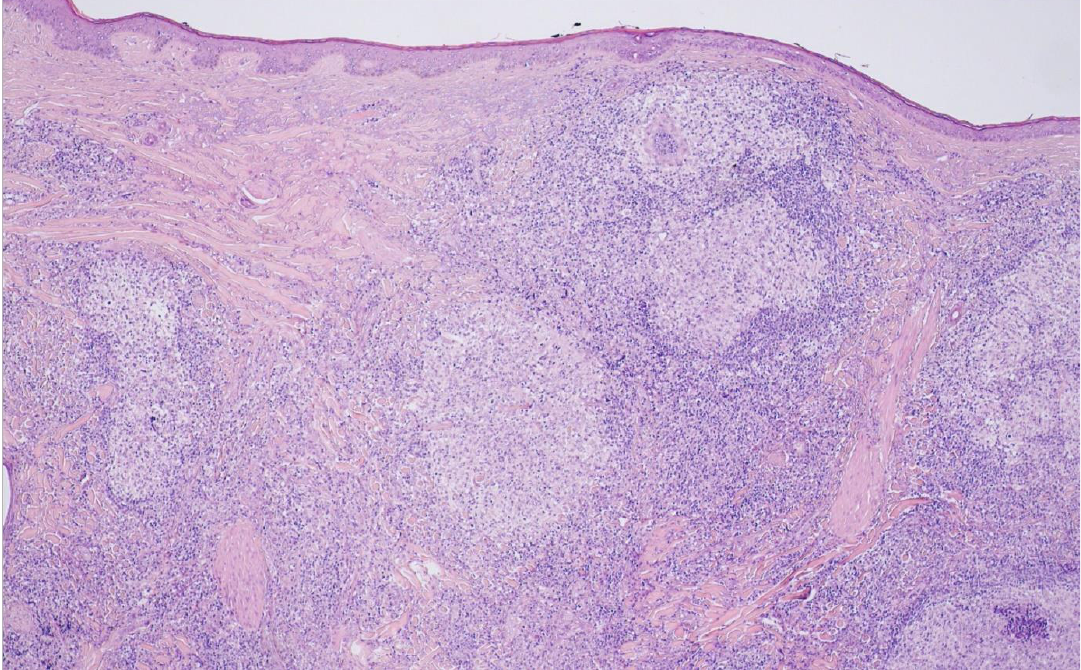
Figure 9. Primary cutaneous follicle center lymphoma (H&E ×20). This example shows atypical fol- licular structures occupying the dermal portions of the skin underneath an intact